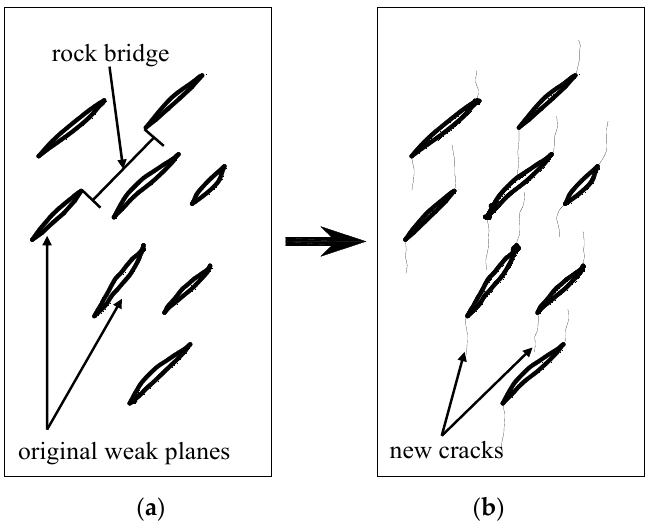
Figure 2. Sketch showing fracture development controlled by discontinuous weak planes under compressive stress. ( a ) Fracture distribution before loading; ( b ) Fracture distribution after loading. When a rock bridge fractures and the fracture connects two weak planes, energy is released.